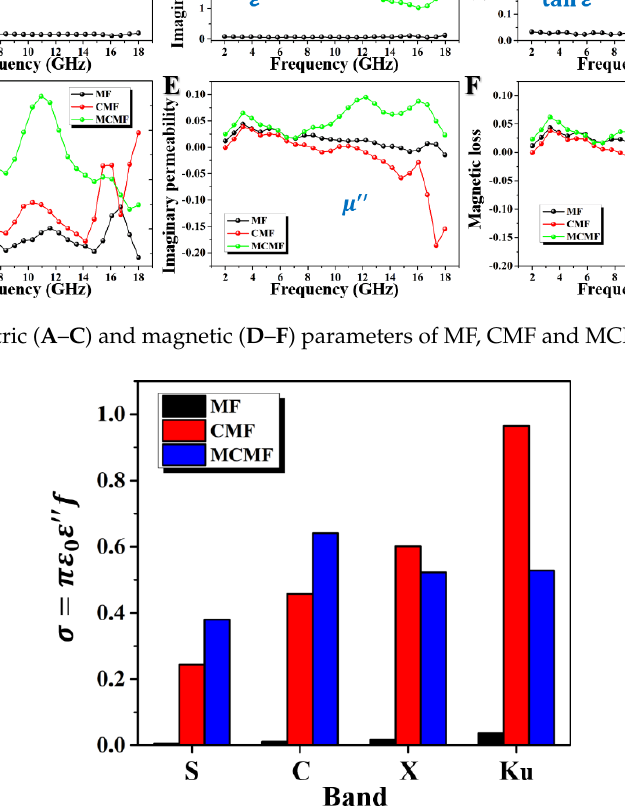
Figure 6. Comparison of electrical conductivity of MF, CMF and MCMF.